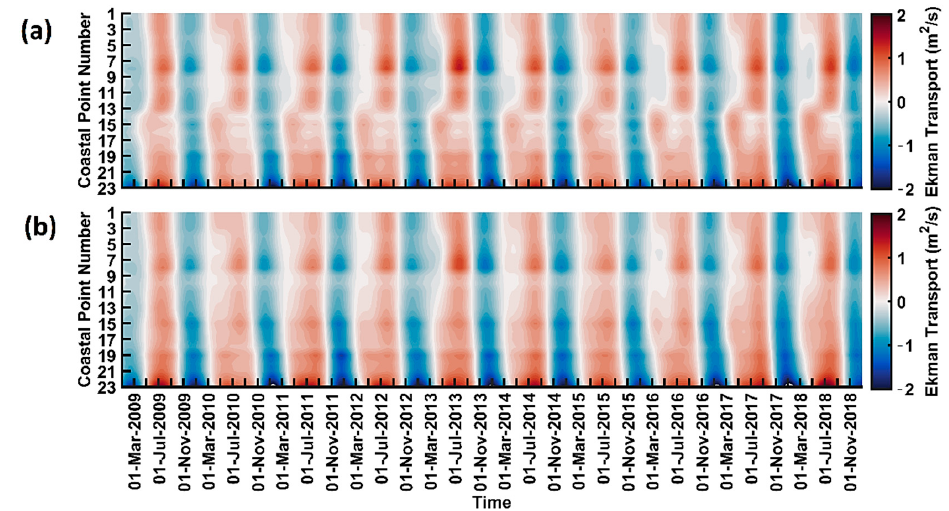
Figure 4. Temporal variation of ET along the coastline for coastal angles computed with tolerance parameter values of ( a ) 0.25° and ( b ) 1.0°.